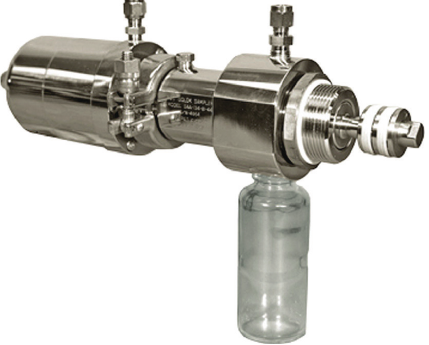
Fig. 11 In-line Sampling Equipment for Pressure Flows. (Courtesy of Sentry